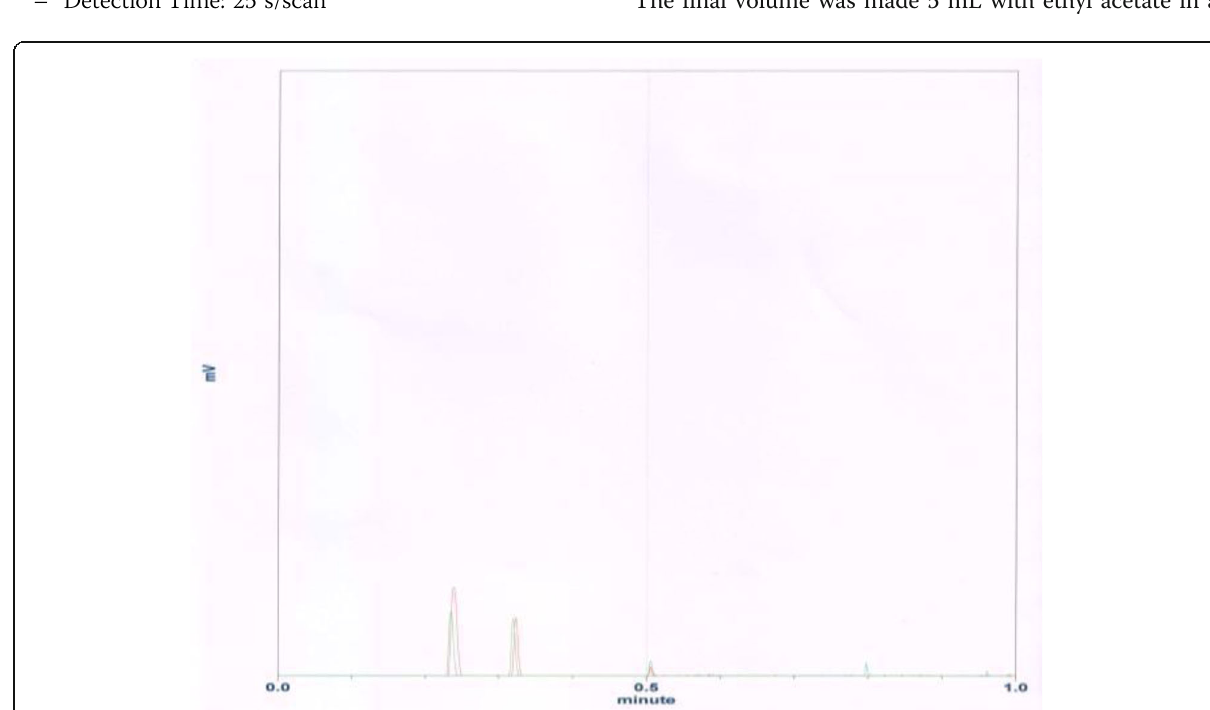
Fig. 2 Chromatogram of chlorpyrifos from grape extract by TLC-FID